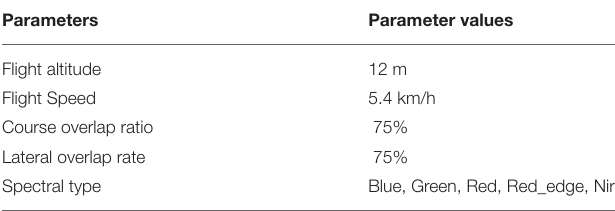
TABLE 1 | Unmanned aerial vehicle (UAV) flight